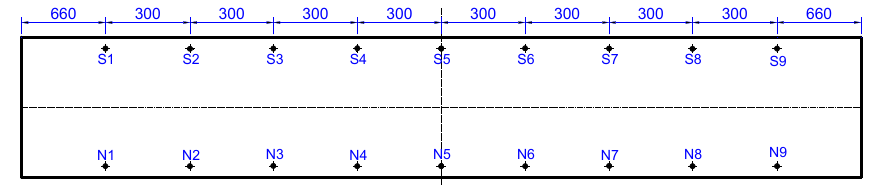
Figure 10. Illustration of the deflection sensor locations (S1:S9, N1:N9) on the bridge deck.